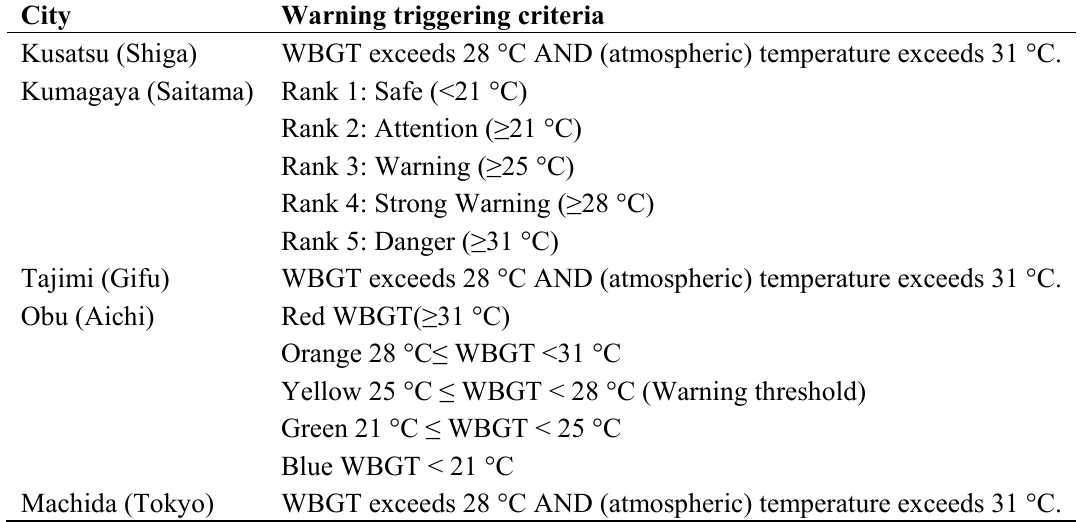
Table 2. Heat alert warning triggering criteria in selected Japanese cities.